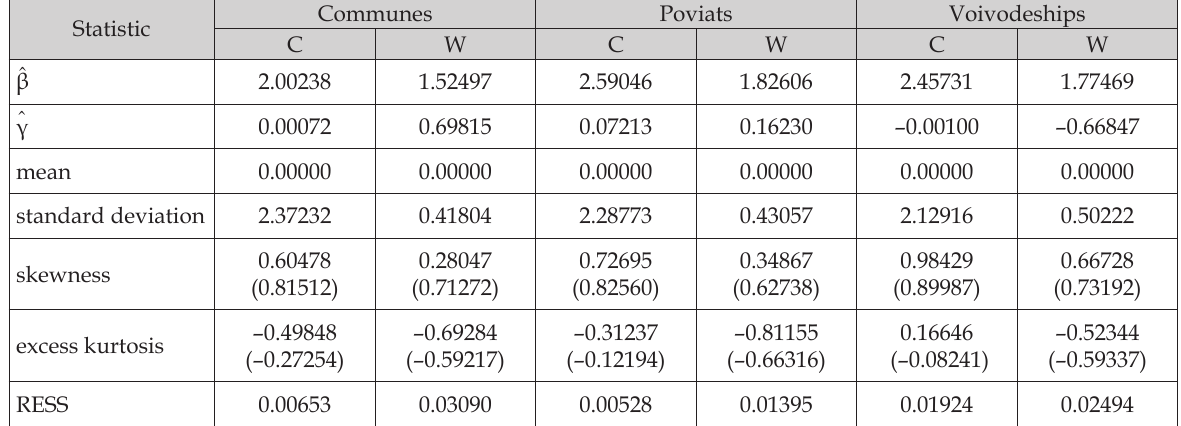
Table 4. Summary statistics for the nested hierarchy of surface partitions for Poland